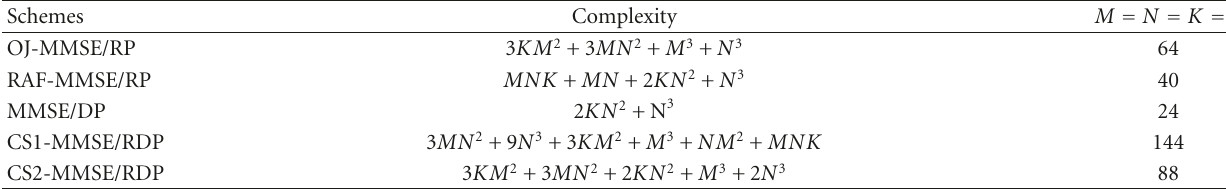
Table 2: Computational complexity ofthe proposed schemes in uplink